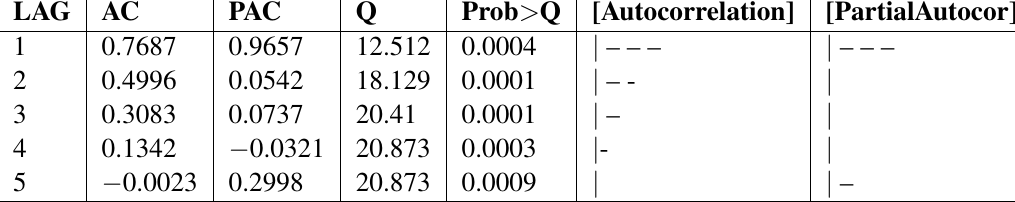
Table 2 Autocorrelation and Partial Autocorrelation Test of Granted Green Patent